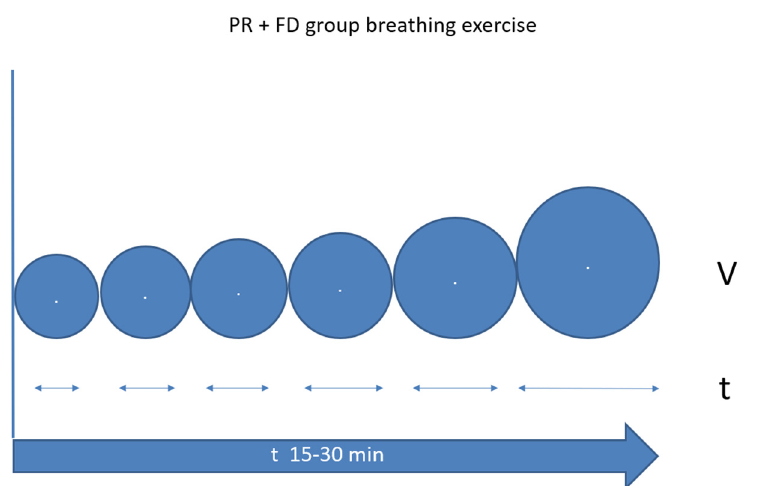
Figure 4. Schematic figure of breath-hold time and volume change during PR + FD rehabilitation. FD: freediving training, PR: pulmonary rehabilitation.